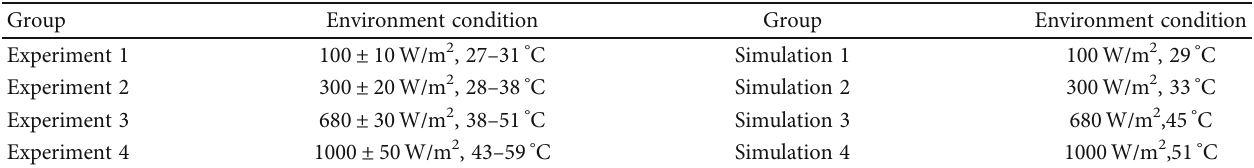
Table 3: Environmental conditions of experiment and